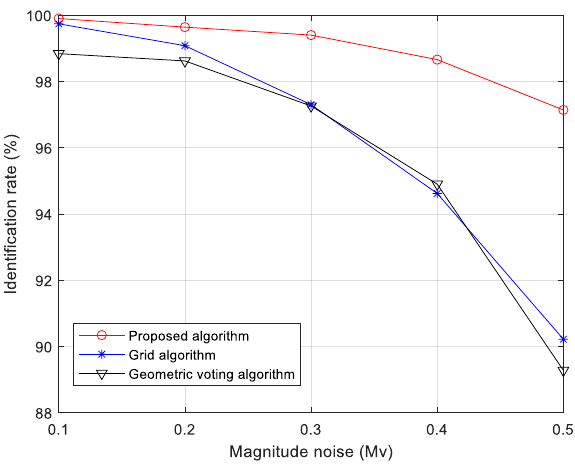
Figure 13. Identification rate versus magnitude noise.